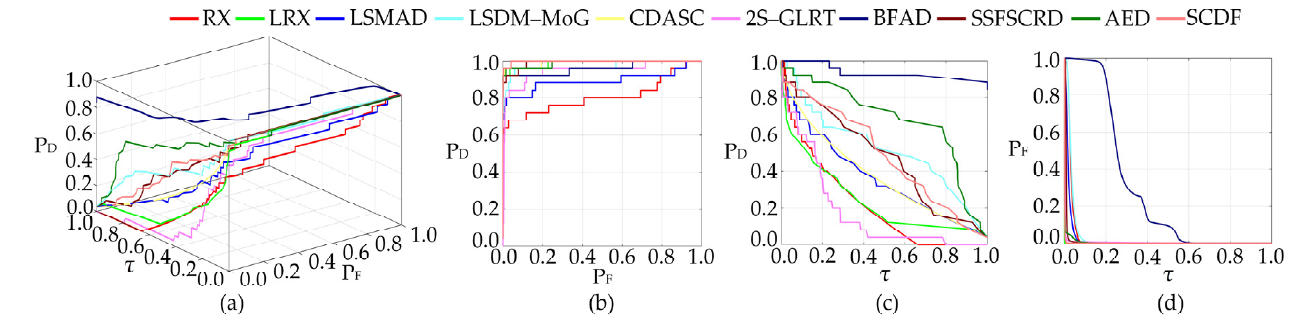
Figure 12. The 3D ROC curve and corresponding 2D ROC curves of different methods on the syn-